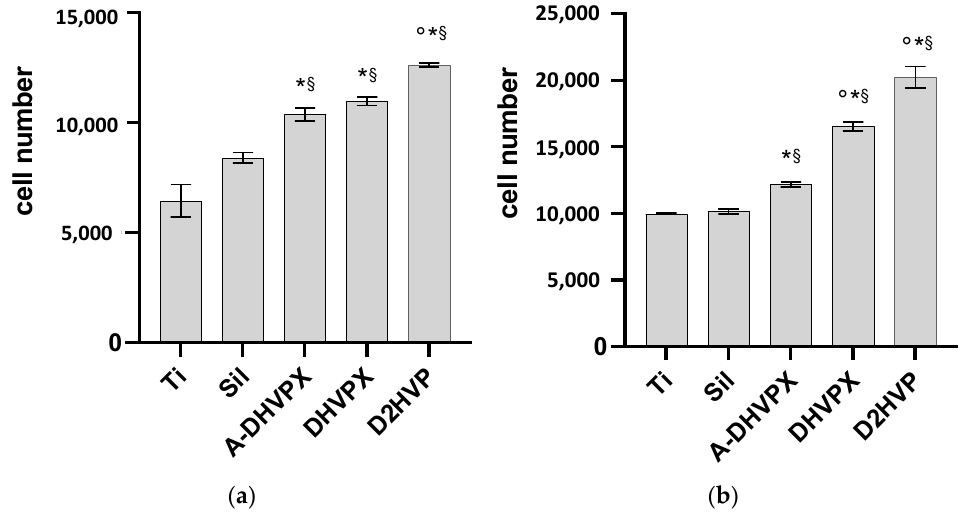
Figure 2. Adhesion and proliferation assays. Adhesion of h-osteoblast cells was assessed at 2 h incubation ( a ) whereas cell proliferation was measured following 24 h incubation ( b ) on differently functionalized Ti disks. “Ti” represents sandblasted and oxidized titanium disks. “Sil” represents the silanized titanium disks. * Denotes p < 0.05 vs. Sil; § p < 0.05 vs. Ti; ° p < 0.05 vs. A-DHVP.